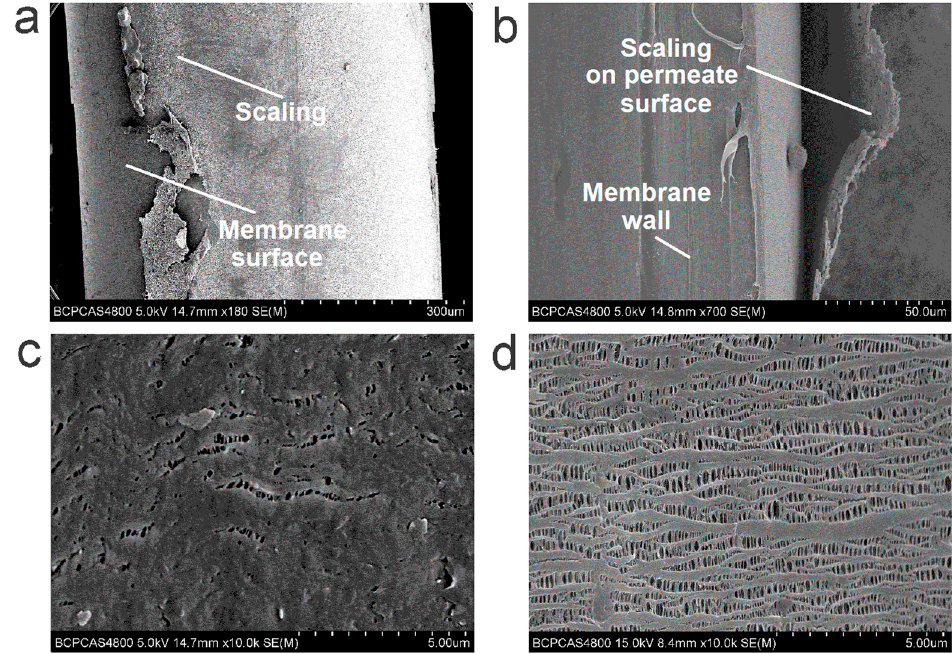
Figure 7. Morphological analysis of membrane samples after 30 batches of VMD tests. Representative morphology of the fouled layer on the outer surface ( a ) and cross-section ( b ); SEM images of the membrane on the outer surface ( c ) and inner surface ( d ).